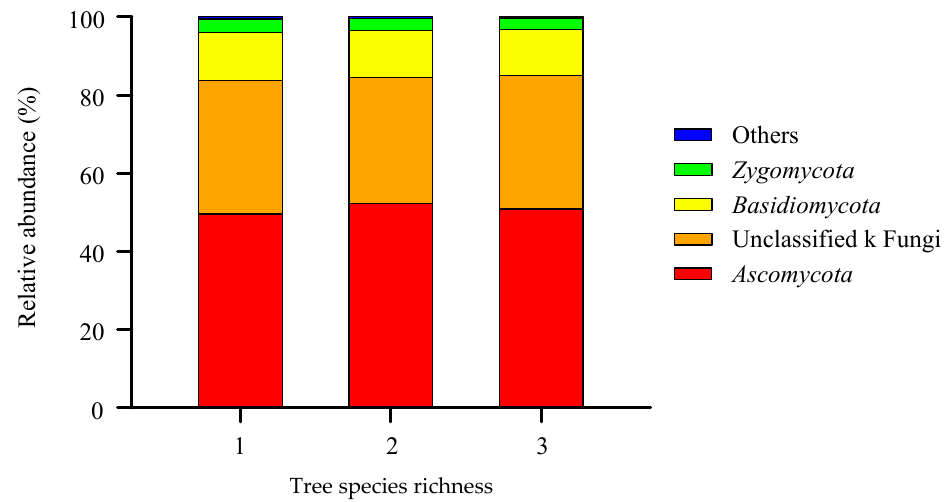
Figure 3. Composition of soil fungal communities (at phylum level) in tree clusters of varying tree species richness, with one, two, and three tree species combinations. Fungal OTUs were used to infer trophic modes to functional groups; ten main functional groups were detected in the Pathotroph, Saprotroph and Symbiotroph trophic groups. The relative abundance of ectomycorrhizal fungi was the highest in each species combination (Figure 4). The relative abundance of ectomycorrhizal fungi decreased with the increase of tree species richness, accounting for 82.38%, 78.20%, and 63.15% in one tree species, two tree species, and three tree species clusters, respectively. In contrast, the relative abundance of saprotrophic fungi increased, accounting for 0.13%, 1.27% and 1.67%, respectively (Table 1).